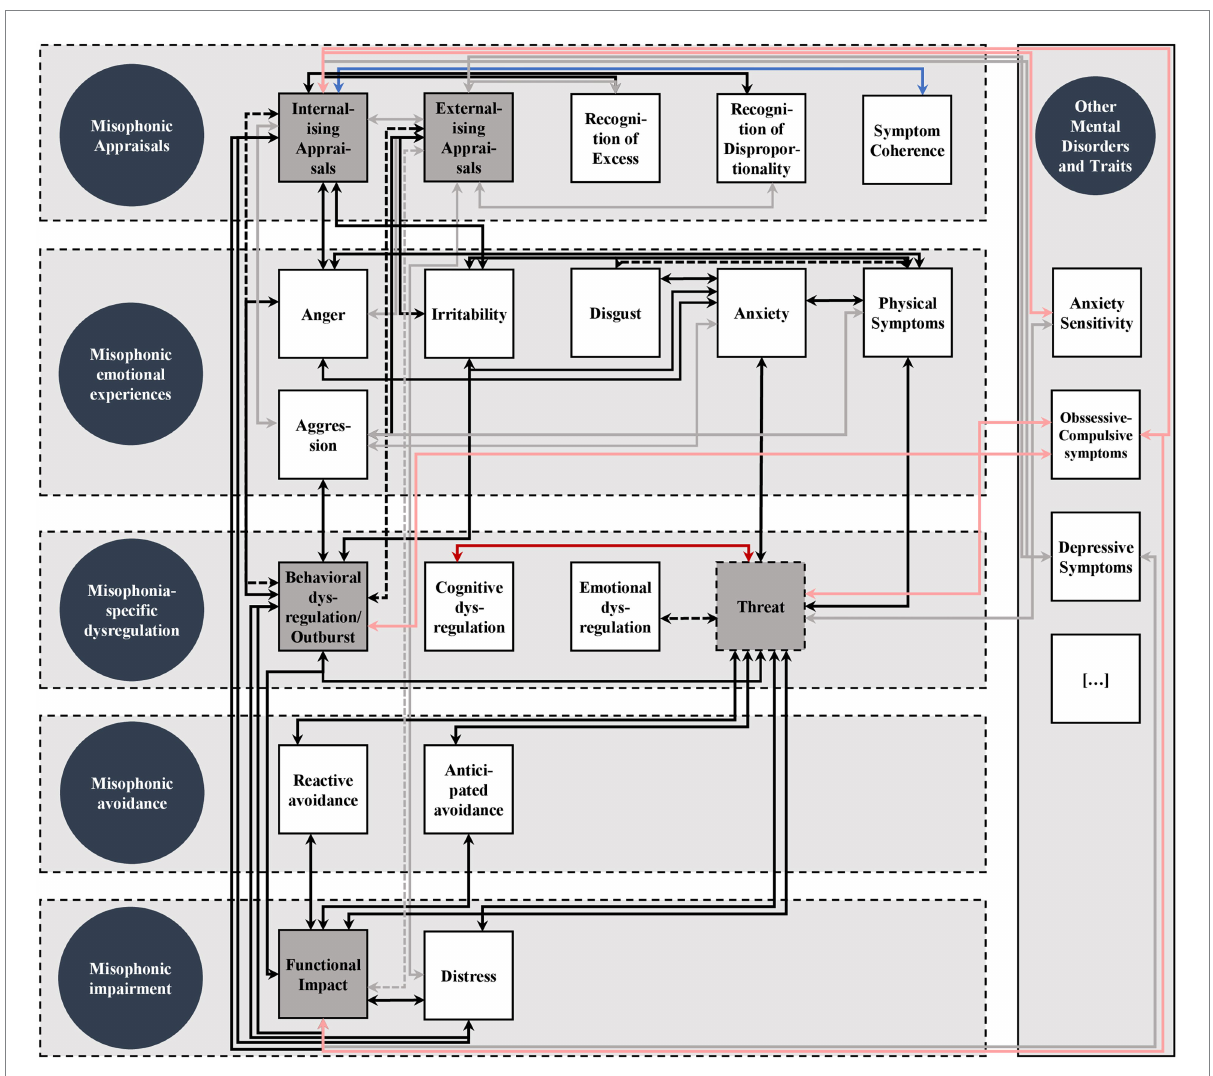
FIGURE 4 Empirical Nomological Network of Misophonic Symptoms. Circles represent proposed misophonic symptom domains. Squares represent specific misophonic symptoms. Grey squares represent symptoms being measured by the S-Five scales. Dashed lines around symptoms within symptoms domains shall indicate that symptom domains are not strictly separated. Strong associations are indicated by black arrows, weaker associations are grey, negative associations are blue with less negative associations in light blue, exploratory associations are red with weaker associations in light red, dashed arrows indicate uncertainty due to mixed